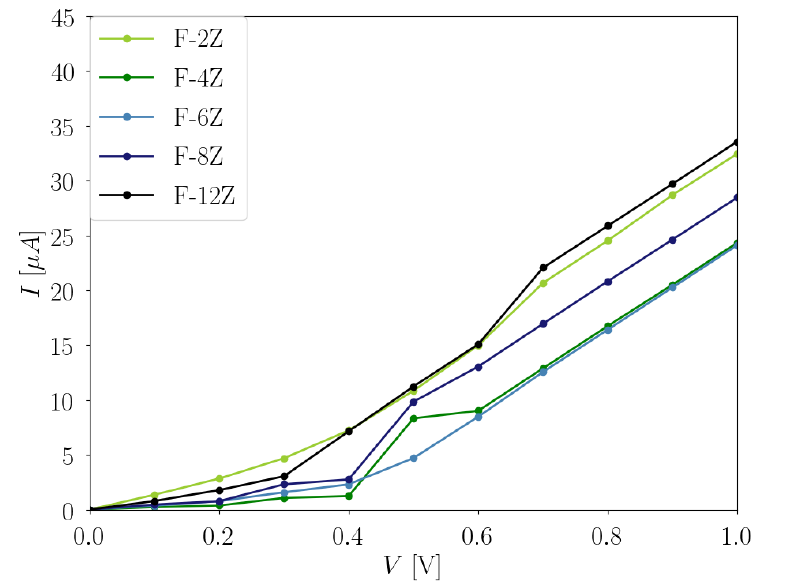
Figure 8. Total current I (µA) in dependence of the applied bias voltage V (V) with 0.1 V step for the F- X Z transport model, where X = 2, 4, 6, 8, and 12. It is noted that the values evaluated at each 0.1 V step are linearly connected for a better visualization of the evolution in the I with the increasing